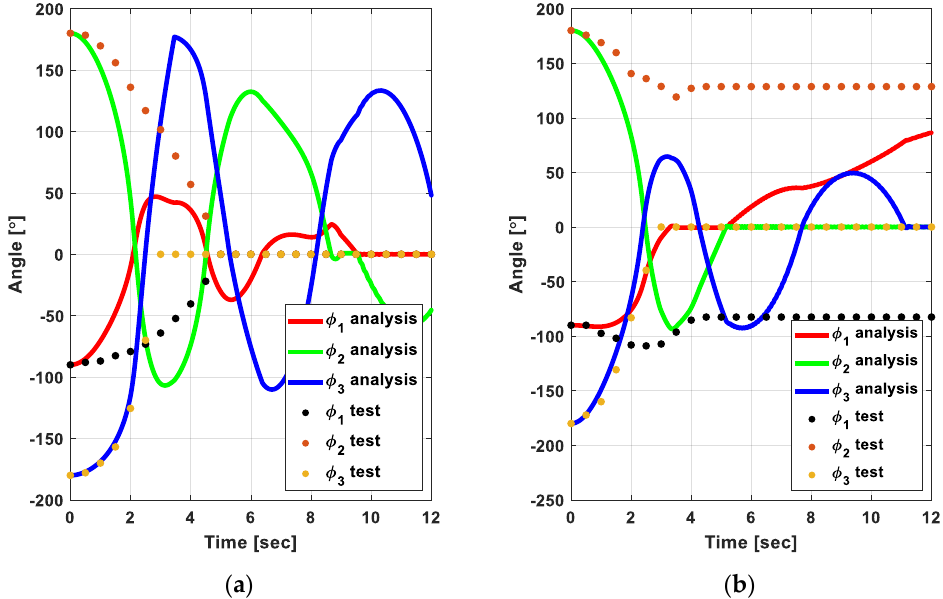
Figure 9. Comparison of the time history of angular displacements for all test cases: ( a ) T01, ( b ) T02.